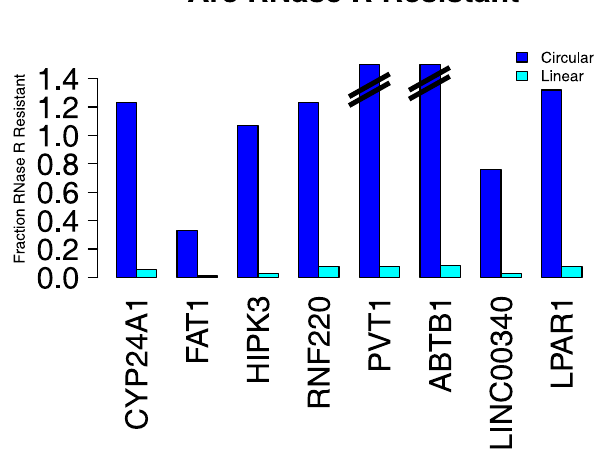
Figure 2. Predicted circular isoforms are resistant to RNase R. HeLa RNA was treated with RNase R or a mock treatment, and then subjected to qPCR with isoform-specific primers. The fraction of linear and circular isoforms was normalized to the value measured in the mock treatment. All tested circular isoforms resisted RNase R, including CYP24A1 (1106 nt), FAT1 (3283 nt), HIPK3 (1099 nt), RNF220 (742 nt), PVT1 (410 nt) and ABTB1 (130 nt). The depletion of the FAT1 circle (the largest circle tested) by RNase R may be due to occasional nicking by contaminating endonuclease activity. We hypothesize that the appar- ent increase in abundance of some upon RNase R treatment is due to more efficient priming in the RT after linear and ribosomal RNA depletion.